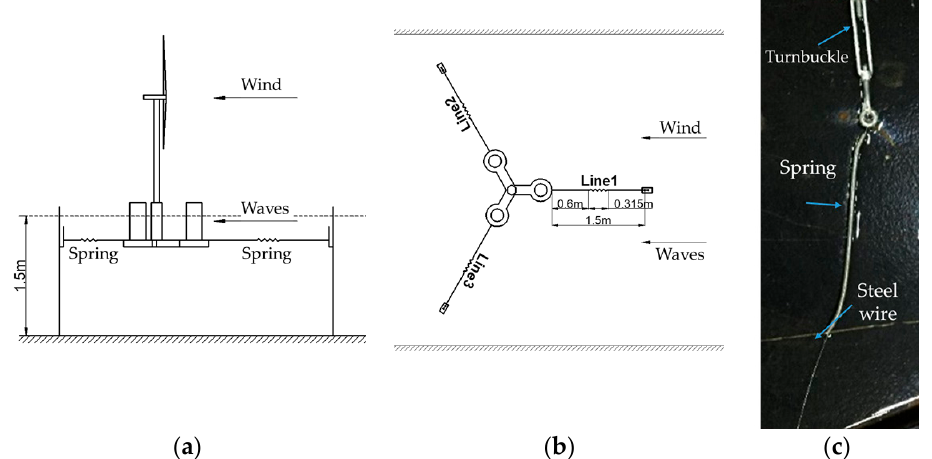
Figure 4. Arrangement of the spring mooring system (under 0 ◦ load direction) in ( a ) lateral view ( b ) top view and its ( c )